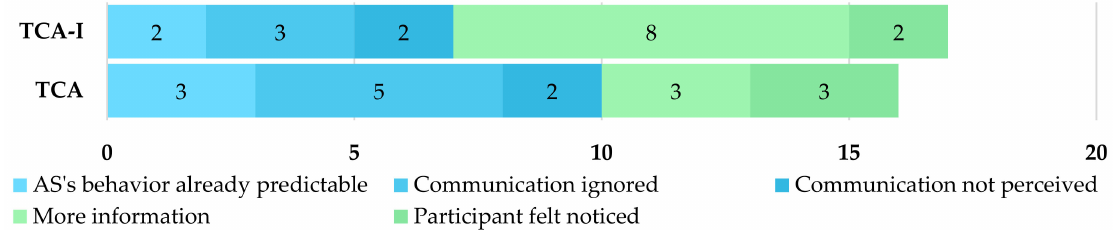
Figure 8. Comprehensibility and predictability: distribution of results according to test condition. (Interview question